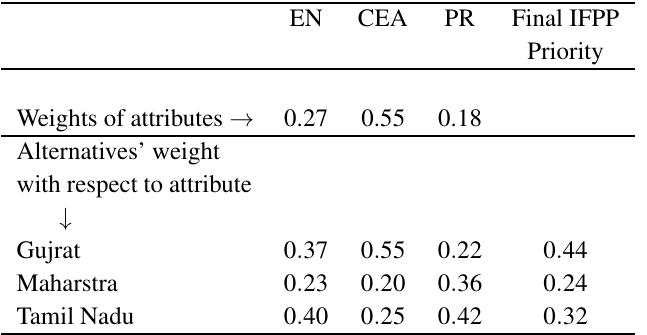
Table 9. Priority weight of the alternatives with respect to goal EN CEA PR Final IFPP Priority Weights of attributes → 0.27 0.55 0.18 Alternatives’